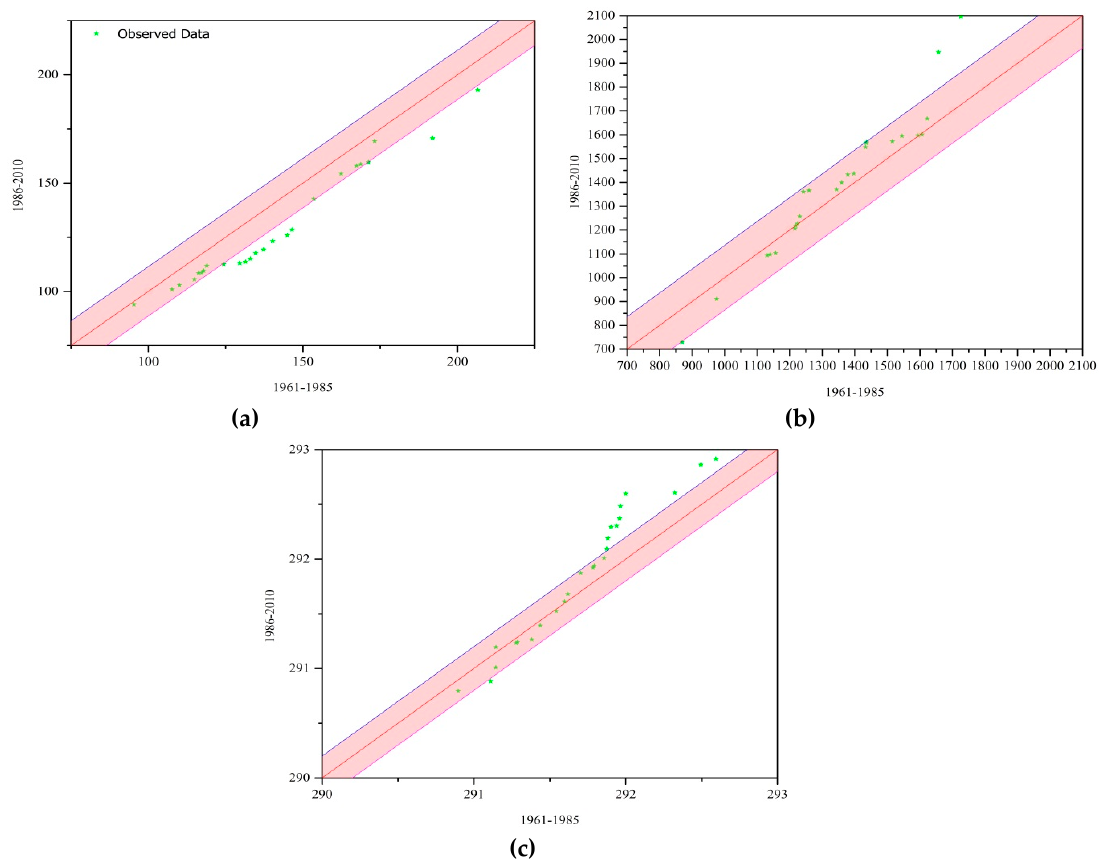
Figure 8. Annual innovative trend analysis (ITA) statistics for precipitation, runoff and temperature for Zone II. ( a ) precipitation, ( b ) runoff, ( c ). temperature Table 2. Summary of the trend analysis for Zone